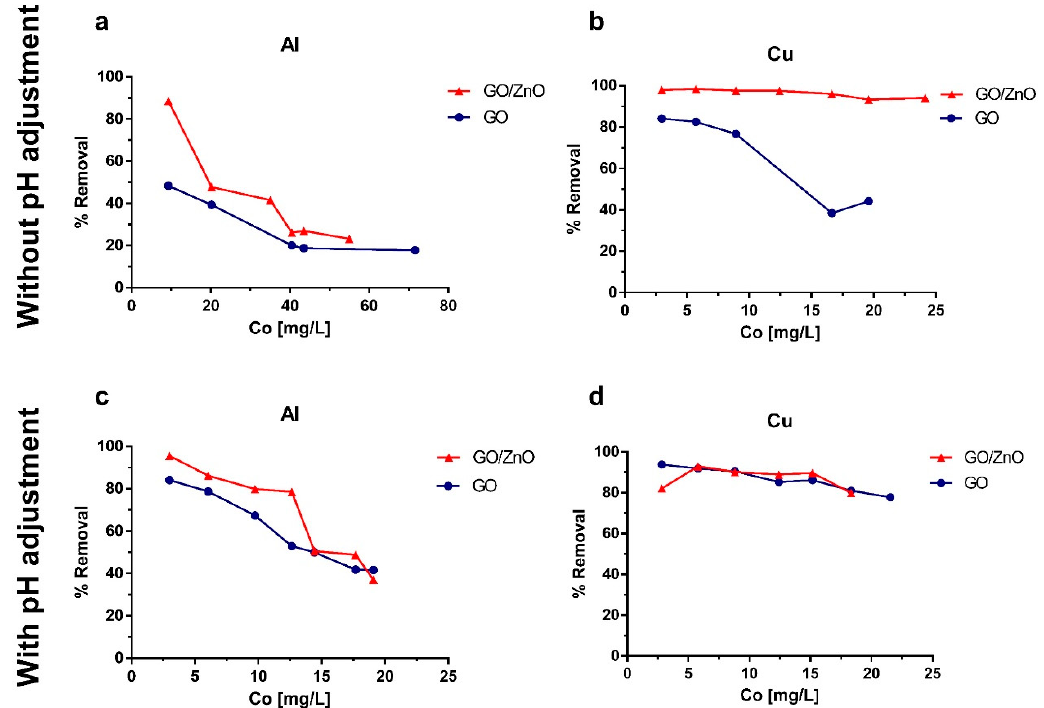
Figure A1. Removal percentages for ( a ) Al and ( b ) Cu in experiments without pH adjustment and for ( c ) Al and ( d ) Cu in experiments with pH adjusted to 4.